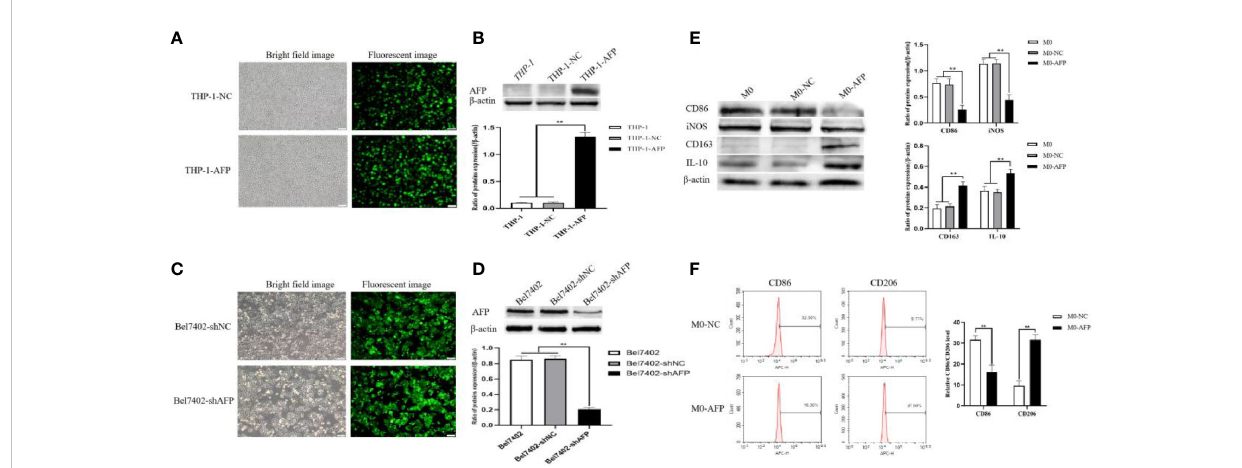
FIGURE 2 Establishment of stable overexpression of AFP in the THP-1-cell line and stable interference with AFP expression in the Bel7402 cell line, and AFP in fl uences the expression of macrophage markers. (A) Fluorescence microscope was applied to observe the expression of GFP in THP-1 cells while infected with AFP-expressing negative control lentivirus vectors (M0-NC) or AFP-expressing lentivirus vectors (M0-AFP) after 48 h. (B) The expression of AFP was detected by Western blotting; the low column diagram shows statistical analysis of the expression levels of AFP in each